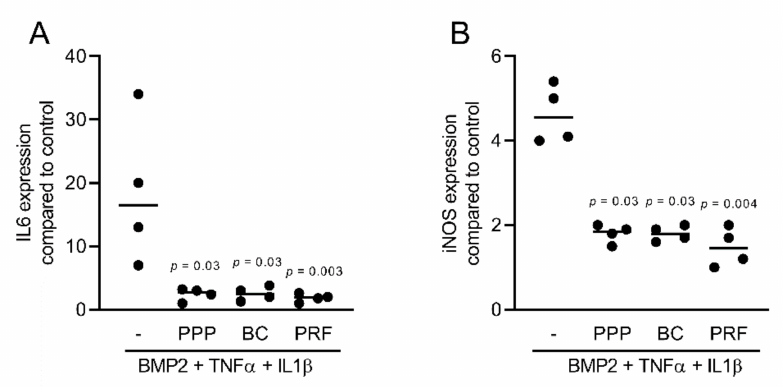
Figure 3. PPP, BC, and PRF lysates reduced inflammation in murine ST2 cells preincubated by BMP2. ST2 cells were treated with BMP2 for 48 h, followed by addition of 10% PPP, BC, and 30% PRF in the presence of the inflammatory cytokines TNF α and IL1 β . ( A , B ) Data indicate the x-fold changes of IL6 and iNOS gene expression, n =